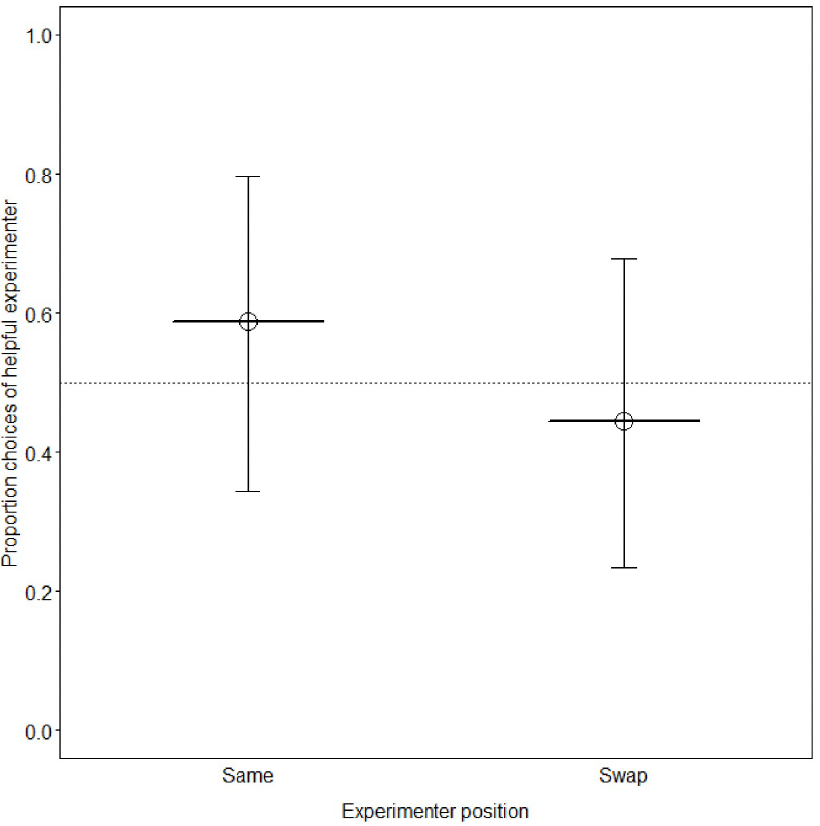
Fig 5. Proportion of dogs that chose the helpful experimenter in the choice test. The solid horizontal lines depict the fitted model and the dotted horizontal line depicts chance expectation.